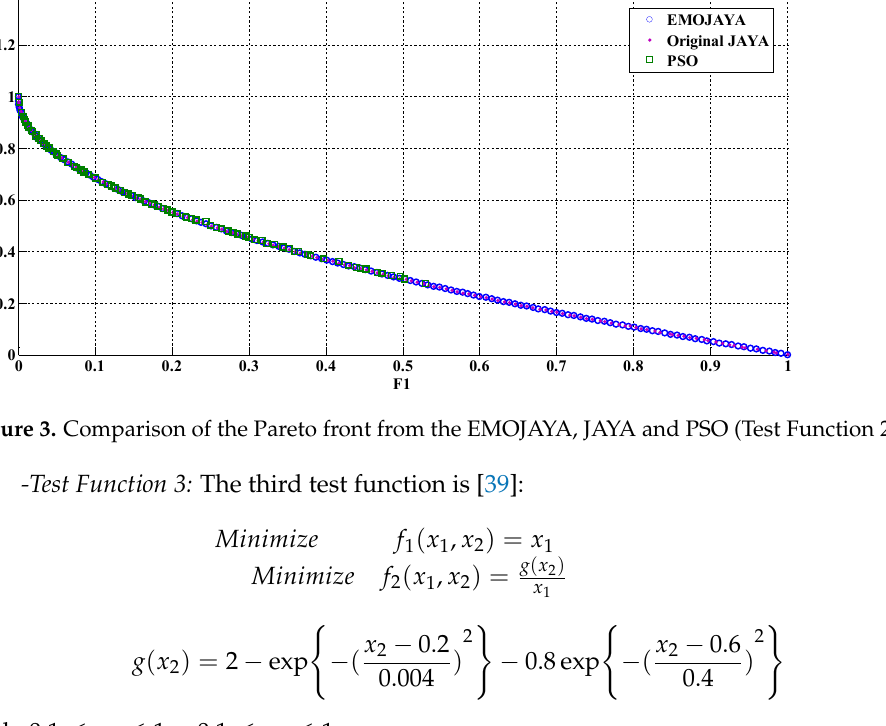
and 0.1 ≤ x 1 ≤ 1, 0.1 ≤ x 2 ≤ 1